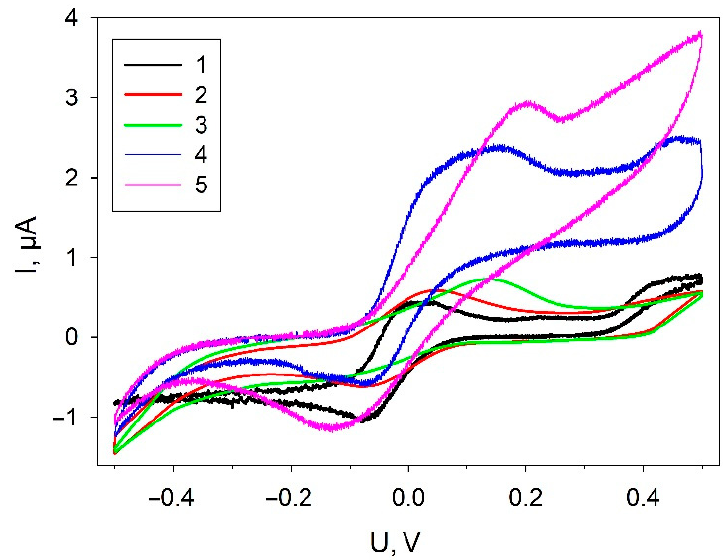
Figure 3. Cyclic voltammograms of electrodes at various biosensor-formation stages: 1, SPE/PEDOT; 2, SPE/PEDOT/graphene; 3, SPE/PEDOT/graphene/Nafion; 4, SPE/PEDOT/graphene/Nafion/ G. oxydans ; 5, SPE/PEDOT/graphene/Nafion/ G. oxydans + 1 mM glucose. Measurements were carried out in the presence of 42 µ M DCPIP; scan rate, 3 mV/s. All dependences exhibit characteristic DCPIP redox peaks, which was used as a re- dox mediator. The addition of graphene to the composite (curve 2) leads to a significant increase of currents in the range from − 400 mV up to 0 mV; the increase is preserved in all the other composites with graphene present. A significant increase of anodic currents in the region of +100 mV up to +500 mV is observed in the presence of bacterial cells. Here- with, the level of anodic currents increases at the addition of glucose into the measuring cell, which is indicative of electron transfer from cells to the electrode in the system.